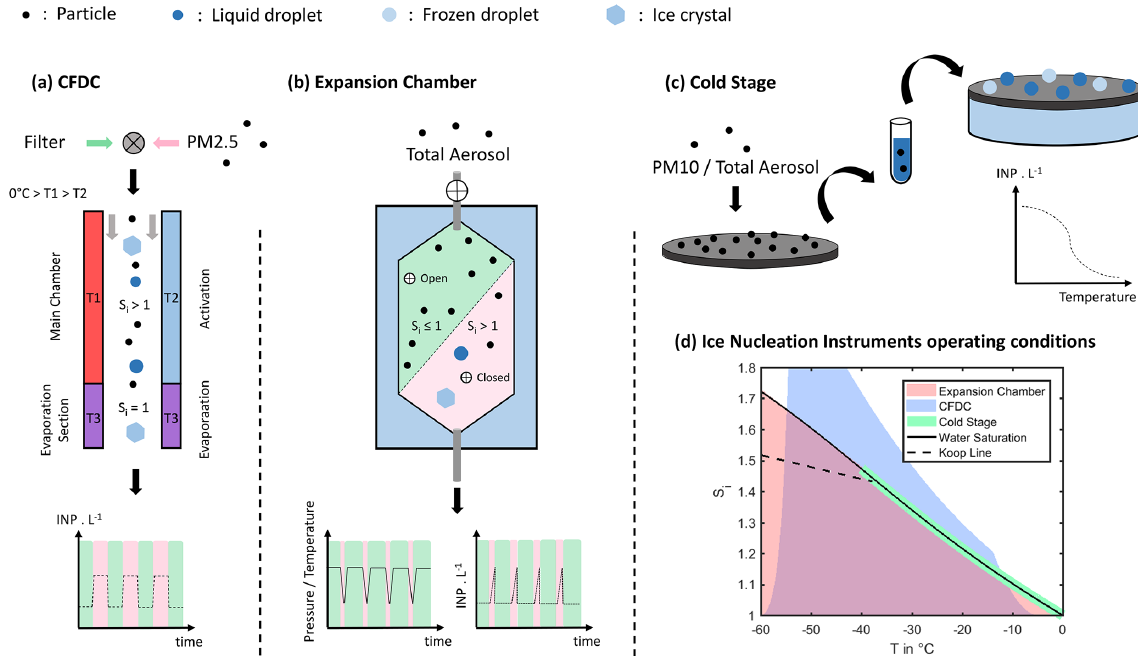
Figure 3. Schematic of the working principles of the INP measurement systems deployed during HyICE-2018. (a) The CFDCs operate with activation and evaporation sections and alternate ambient sampling (pink) and filtered background measurements (green). (b) The PINE expansion chamber samples a volume of ambient air before a short expansion cycle activates INP within the trapped volume. In both (a) and (b) , optical particle counting is used at the chamber exits to measure particle number. (c) The droplet-freezing assays rely on filter sampling of ambient aerosols. Collected particles are washed from the filters and analyzed for INP content, generating curves of INP temperature spectra. (d) The thermodynamic space typically accessible to different measurement